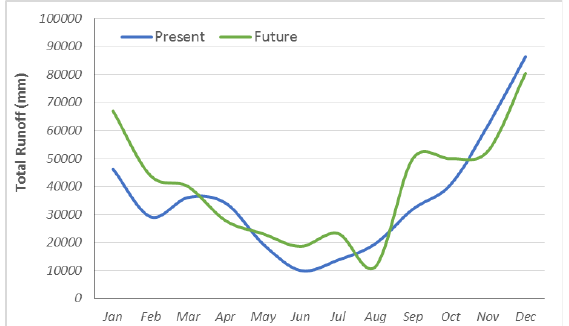
Figure 8. Monthly changes in estimated total runoff under